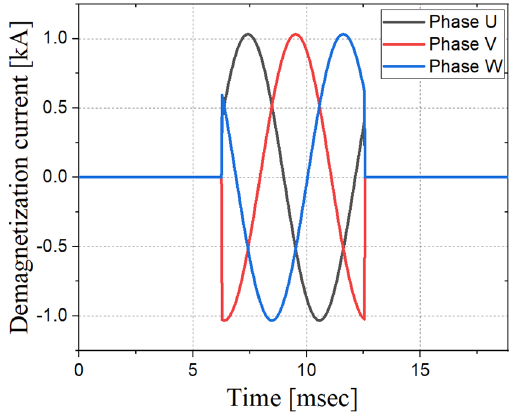
Figure 3. Demagnetization current waveforms.